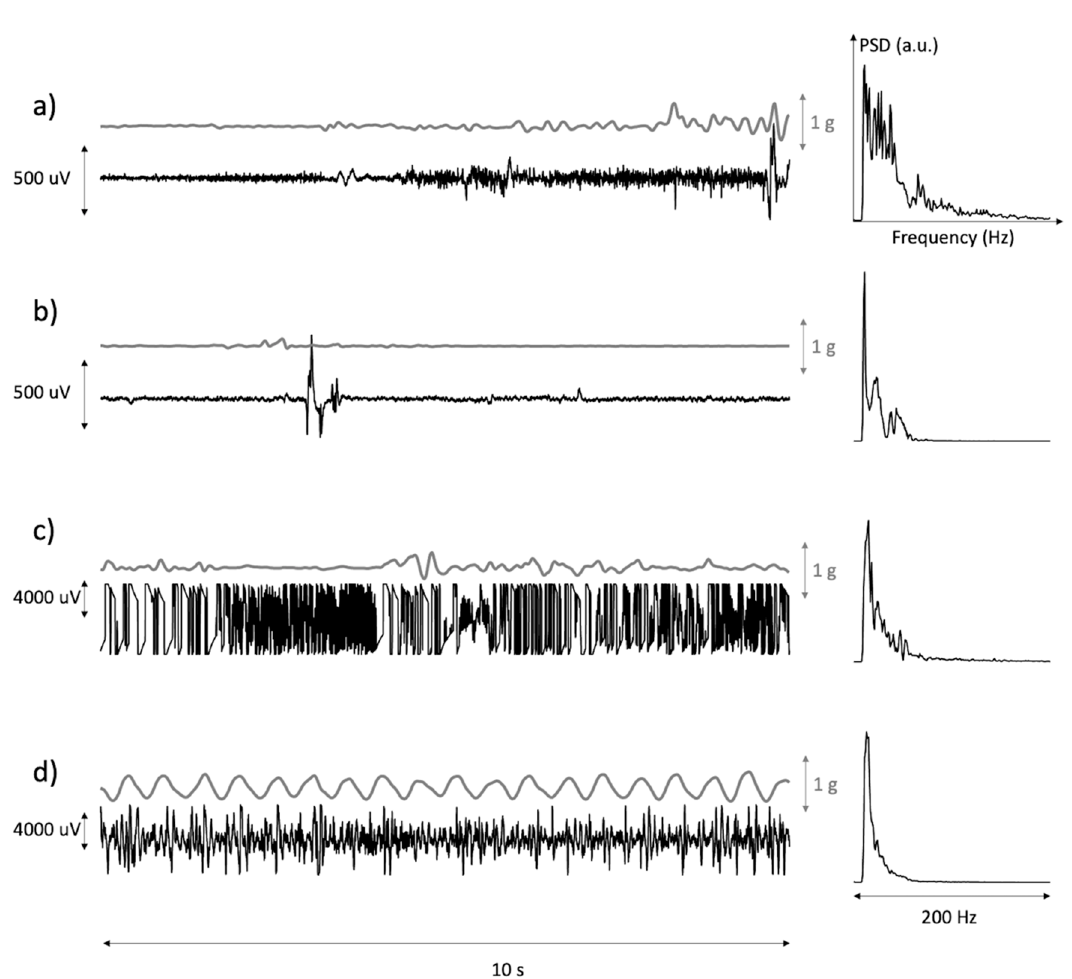
Figure 3. Time plots of the modulus of the acceleration of the EMG sensor and of the associated sEMG with its power spectrum. ( a , b ) are examples of occasional movement artifacts. ( c ) is an example of loss of electrode–skin contact(s) during movement. ( d ) is an example of passive movement of the arm during treatment.